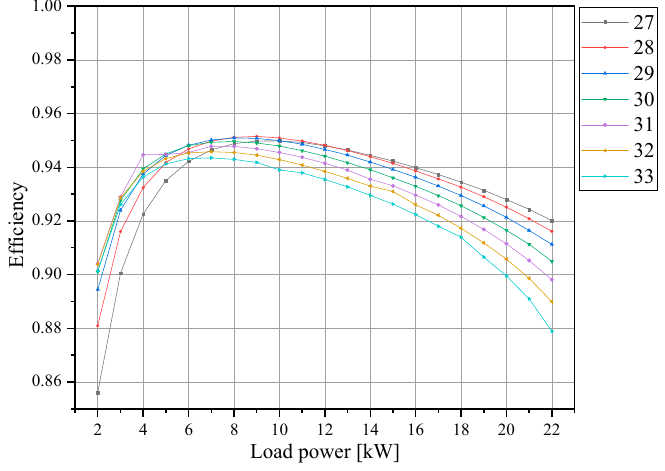
Figure 15. Efficiency with different Ns values versus load power.